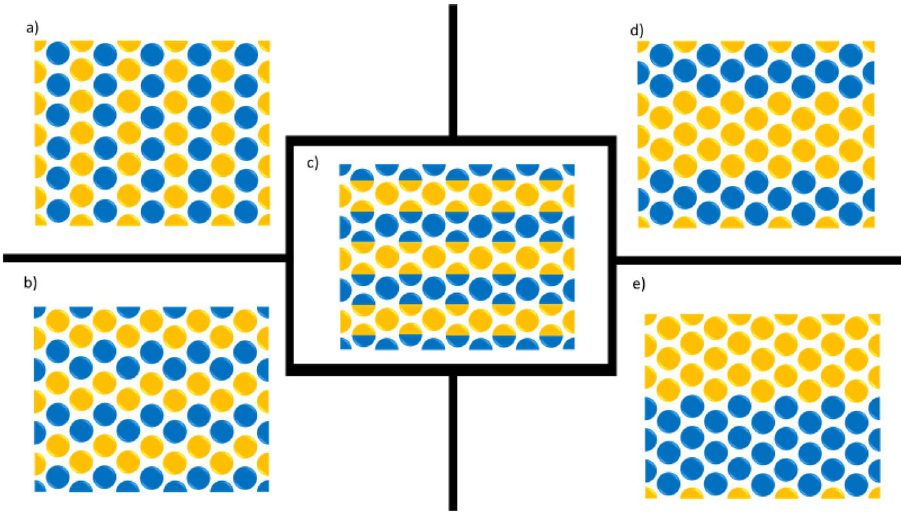
Figure 3. Five different wettability distribution patterns: ( a,b ) ζ = 1, ( c ) ζ = 0.5–1.5, ( d,e ) ζ = 1–2. Wet- and non- wet surfaces are represented by blue and orange,